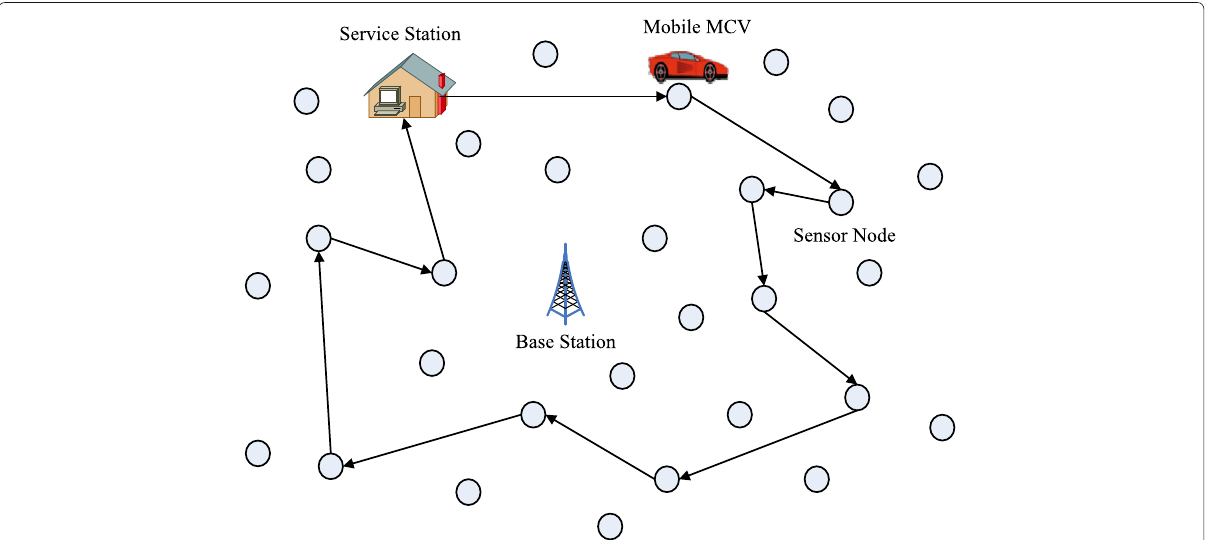
Fig. 1 A wireless sensor network with a mobile charging vehicle (MCV). This is the model for MCV’s behavior. During each cycle, the MCV starts from a service station, visits and charges some nodes in the network, and finally returns to the service station